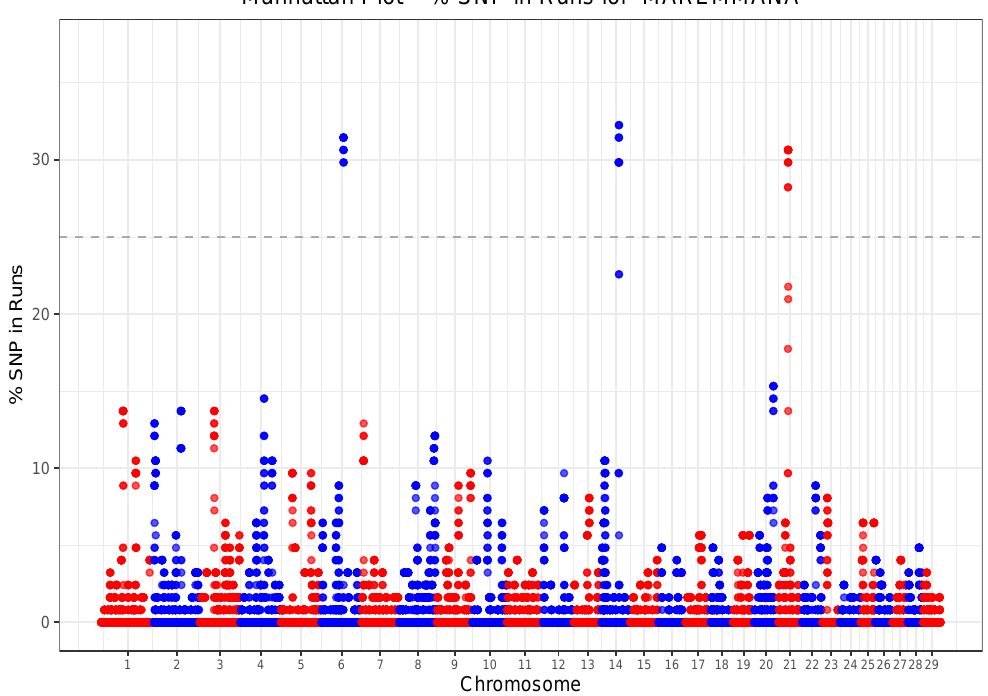
Figure 5. Manhattan plot of the proportion of times each SNP falls within a ROHet (heterozygosity-rich region) in the analysed Maremmana cattle population. The dashed horizontal line is the 25%